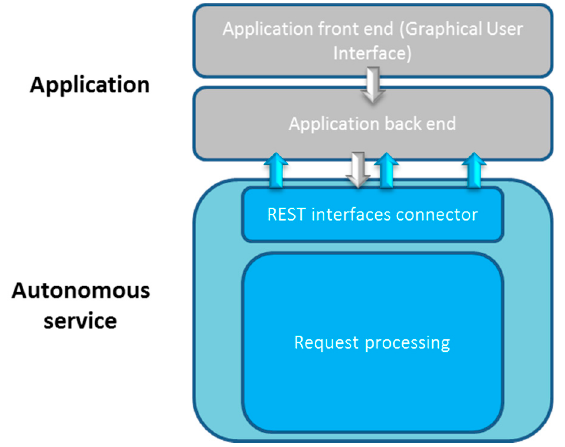
Figure 5. Data request processing done in an Autonomous Service.